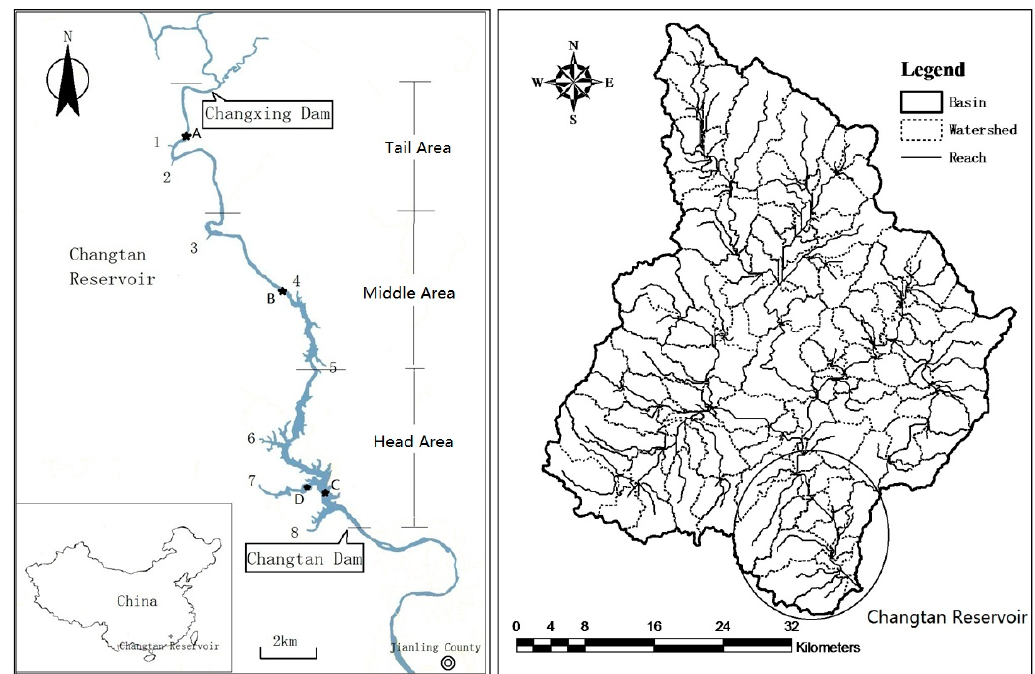
Figure 1. The map of CTR watershed and study area (Numbers 1–8 represent the tributaries, A–D represent the locations for analysis), Changxin Dam on the upstream is the tail area and Changtan Dam on the downstream is the head area in Changtan Reservoir.